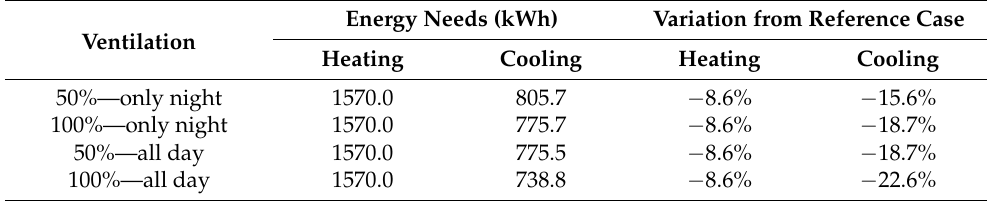
Table 9. Building’s annual energy needs and percentage change relative to the reference case varying ventilation strategy.